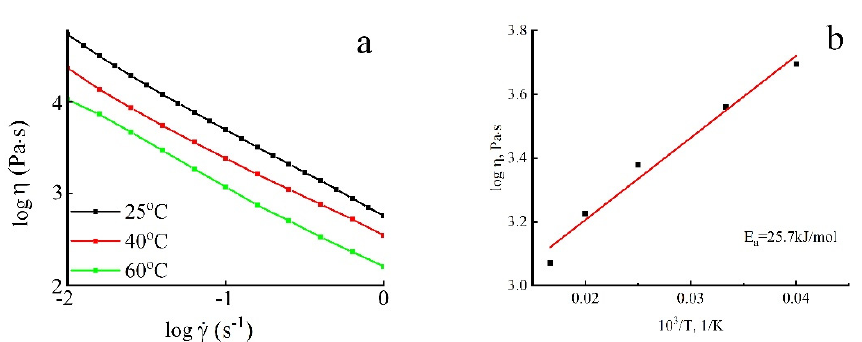
Figure 11. Flow curves of 1.23% BC aqueous dispersion at different temperatures ( a ) and dependence of viscosity measured at γ = 0.1 s − 1 on reciprocal temperature ( b ).